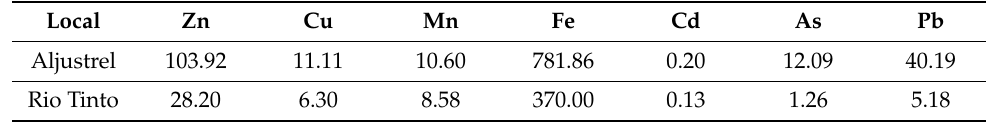
Table 3. Comparison of the Zn, Cu, Mn, Fe, Cd, As, and Pb concentrations (ng m − 3 ) in the PM 10 samples between Aljustrel (Portugal) and Rio Tinto (Spain) of IPB